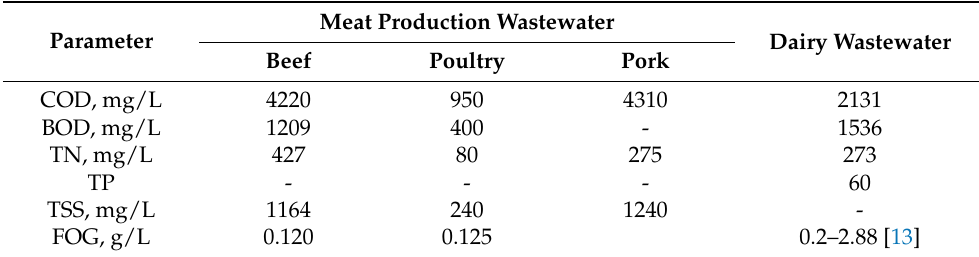
Table 1. Indicative MPWW and DWW chemical parameters comparison before treatment. Adopted from Asgharnejad et al.